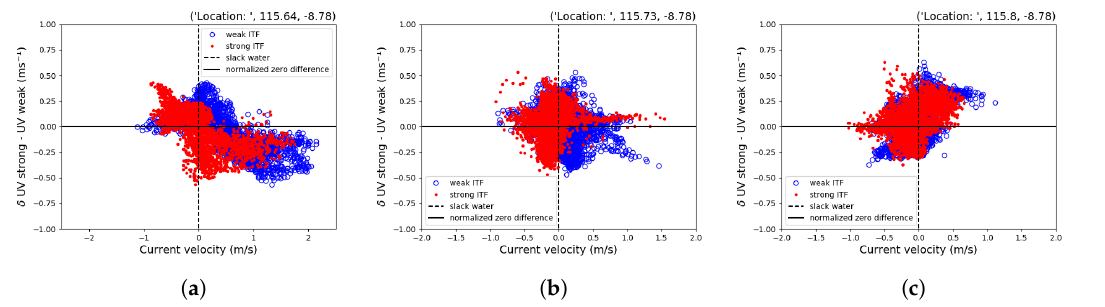
Figure 12. ITF driven variation in tidal flow at western ( a ), middle ( b ) and eastern ( c ) points across the Lombok Strait (see Figure 10). Blue markers indicate the tidal conditions during weak ITF conditions, red markers indicate the tidal conditions when the ITF is